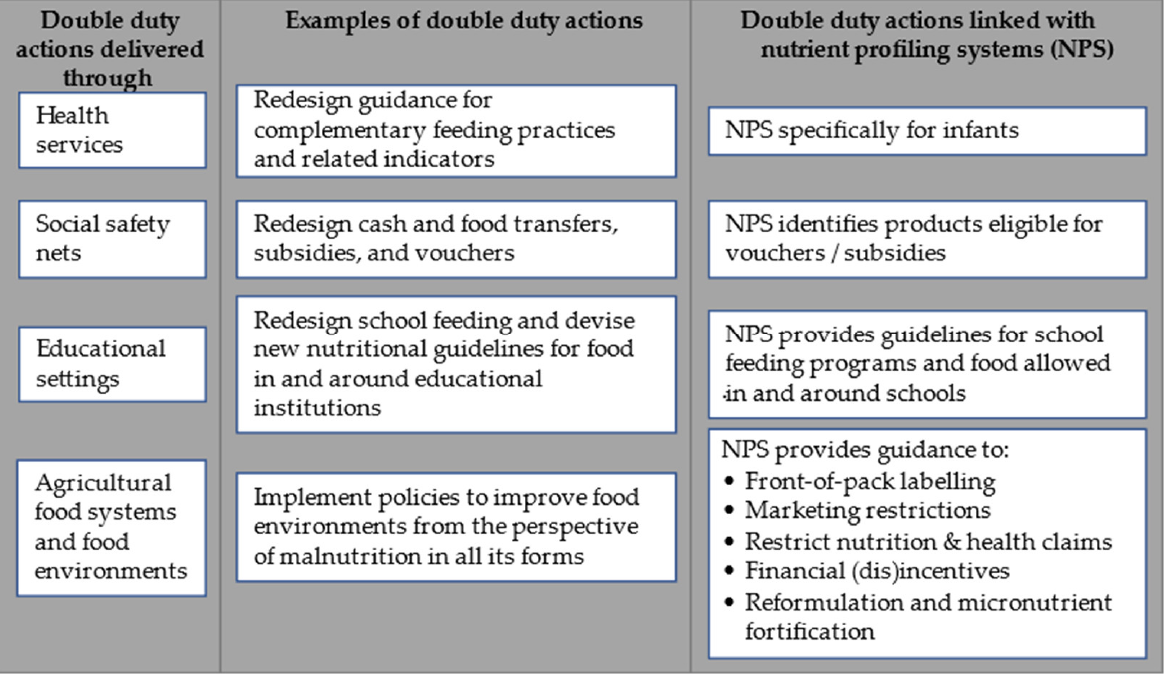
Figure 1. Examples of double-duty actions, addressing undernutrition, obesity, and diet-related non-communicable diseases, listed by Hawkes et al. [5], and how nutrient profiling systems (NPSs) could support them (authors’ analysis).